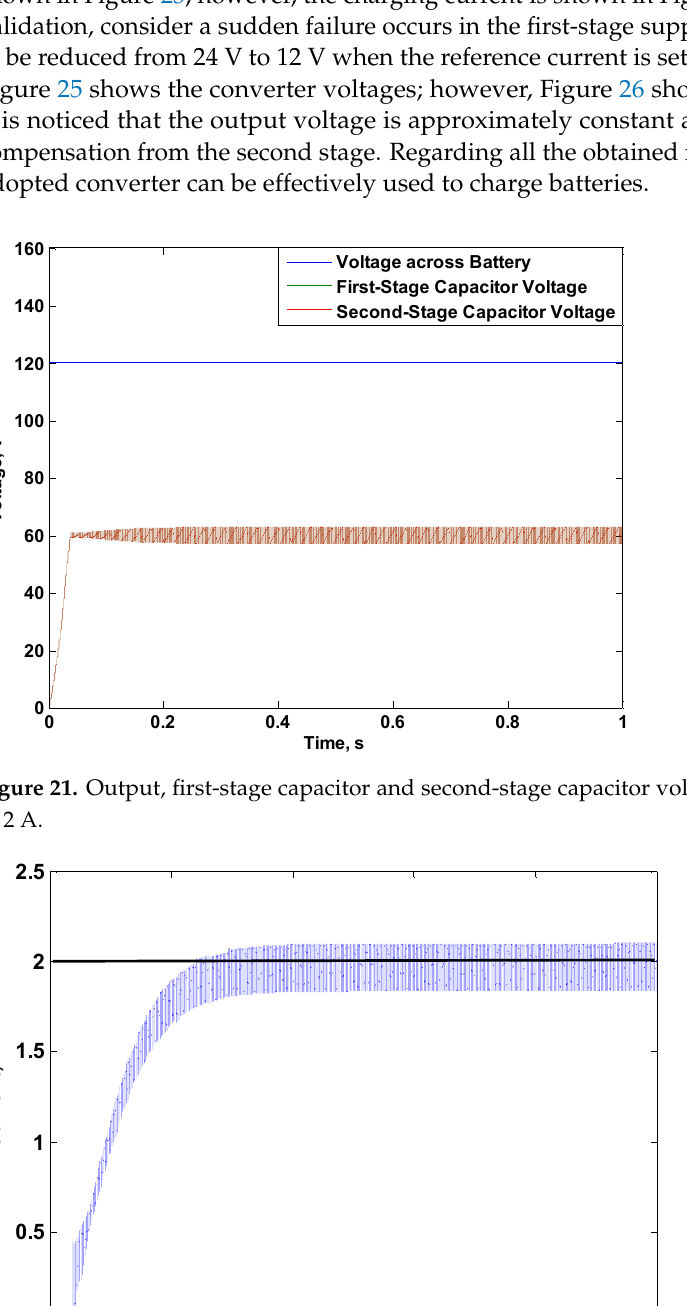
Figure 23. Output, first-stage capacitor and second-stage capacitor voltages at a reference current of 5 A.